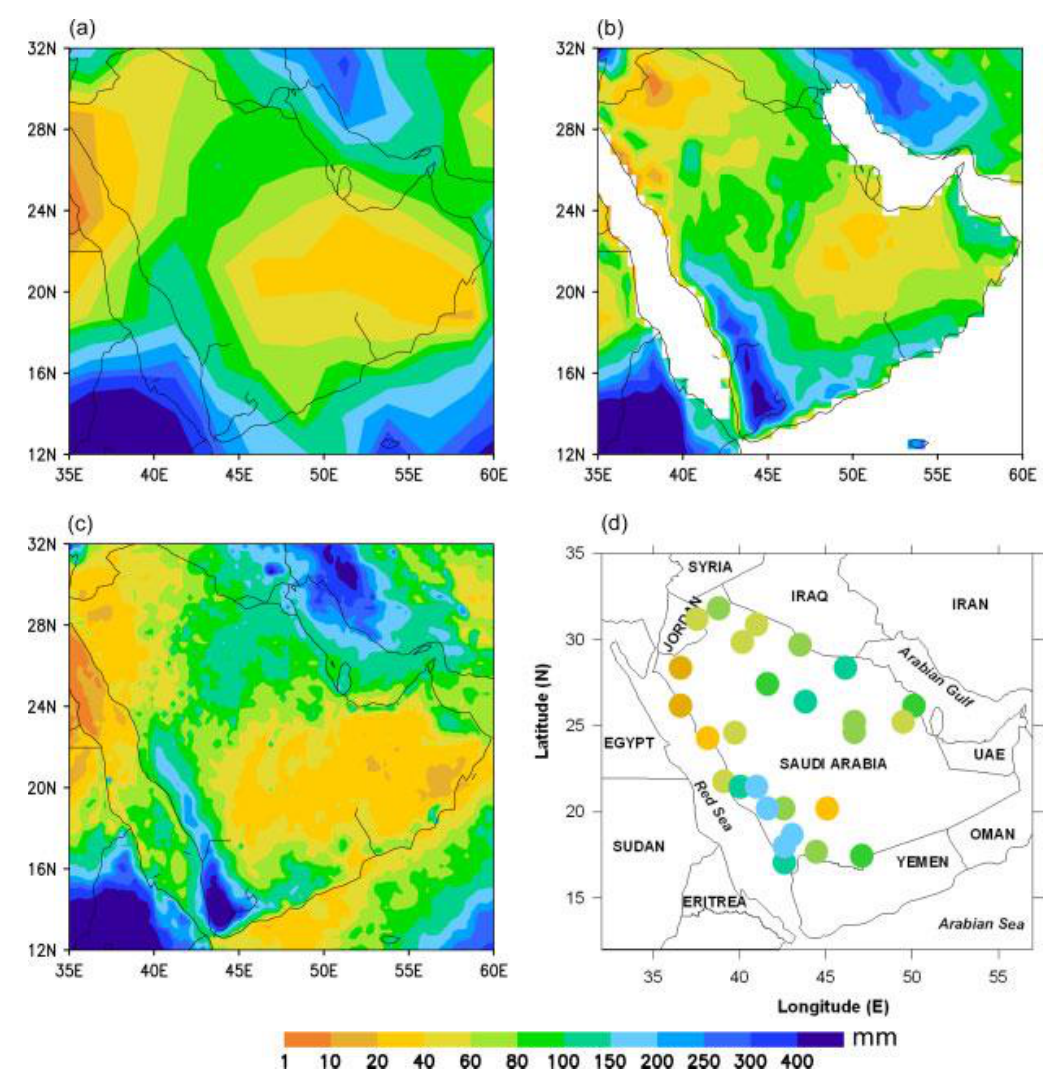
Figure 6. The spatial distribution of the mean annual rainfall (mm) obtained from the ( a ) CMAP; ( b ) CRU; ( c ) TRMM; and ( d ) observed datasets, averaged over 1998–2009